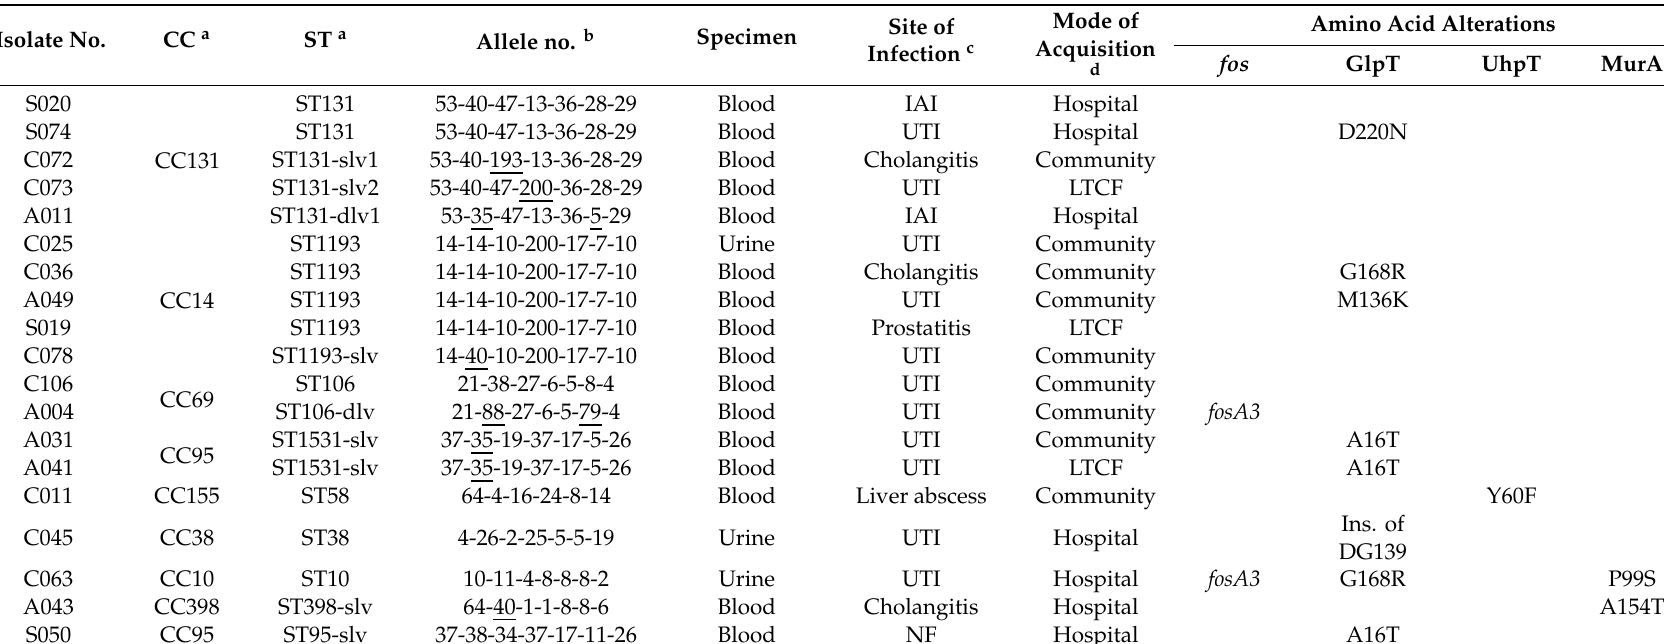
Table 2. Characteristics of 29 fosfomycin-resistant E. coli isolates: genotype, clinical characteristics, and amino acid alterations in genes associated with fosfomycin